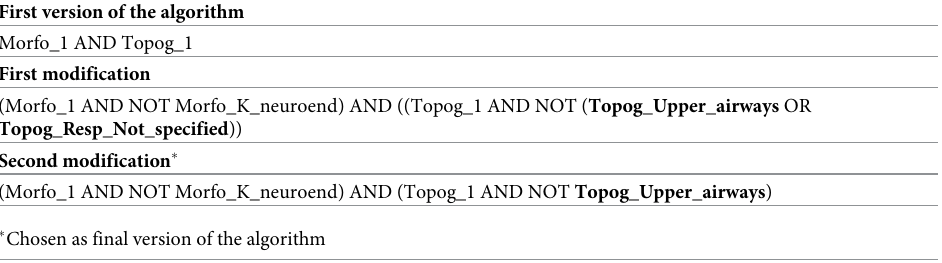
Table 3. First version of the algorithm and algorithm modifications.